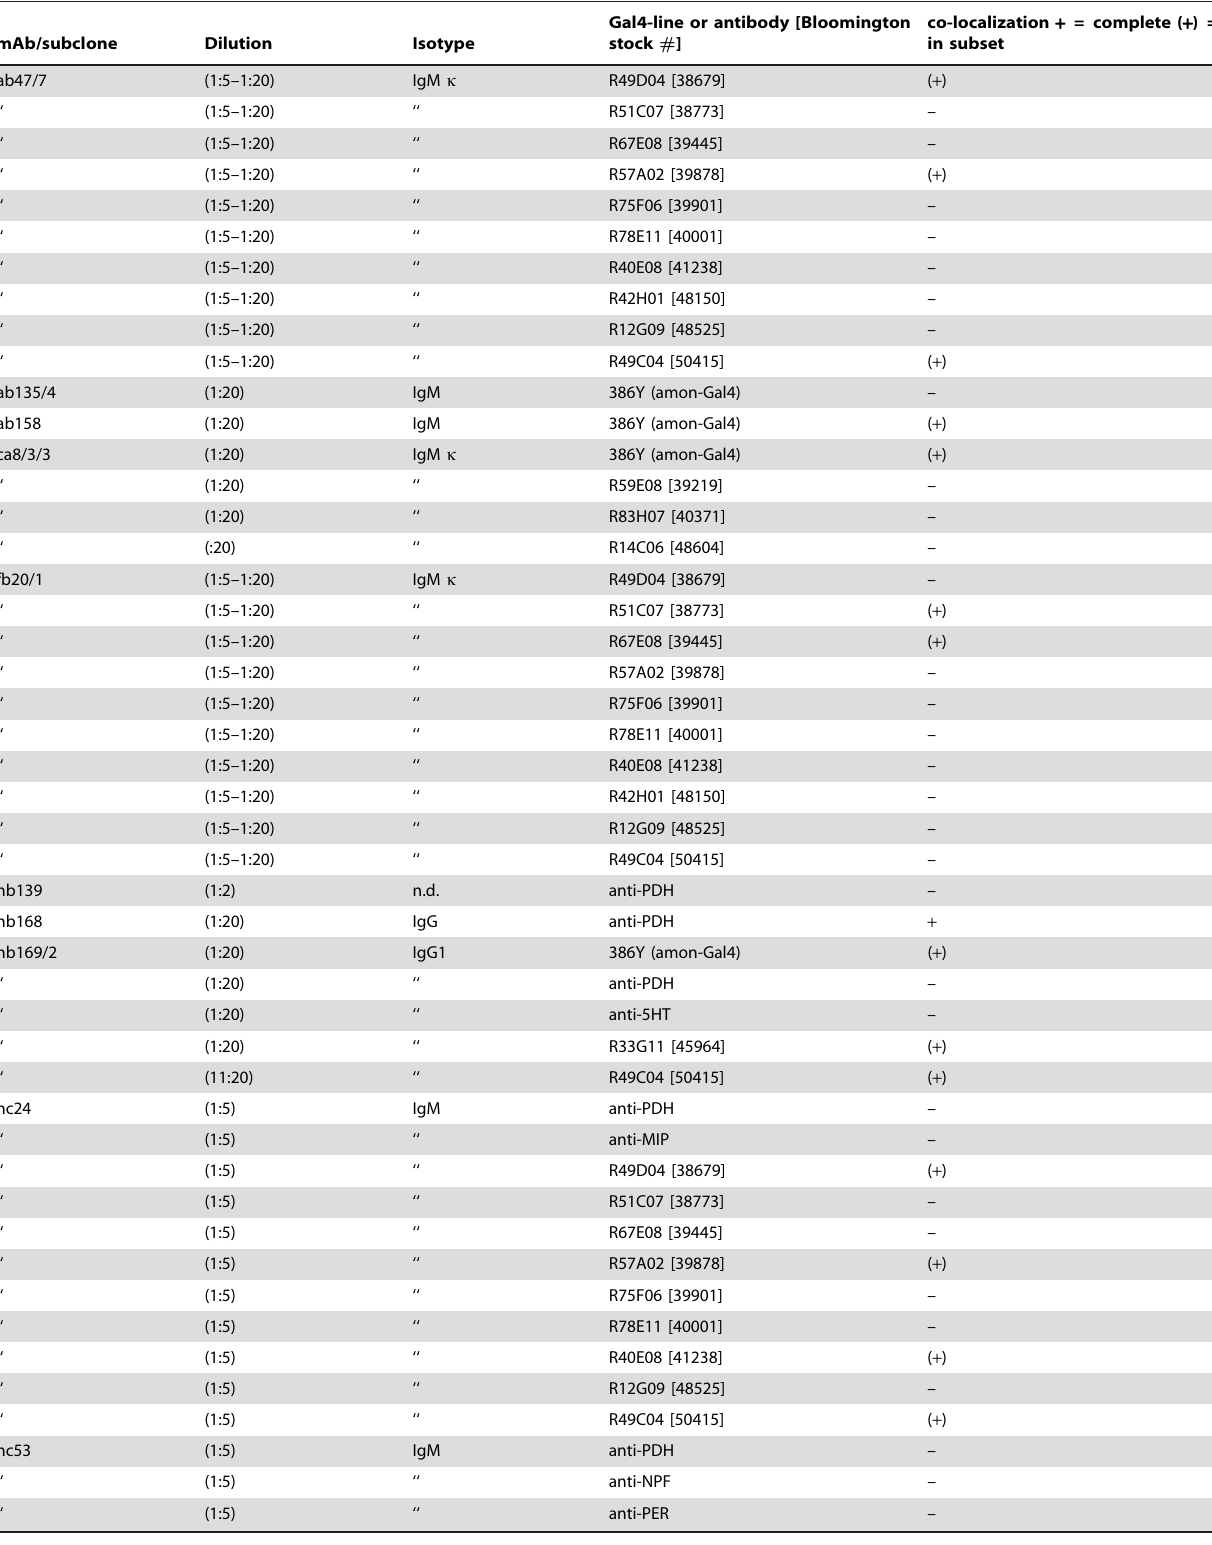
Table 1. List of mAbs compared with GFP (detected by anti-GFP (1:1000) driven by Gal4-lines) or stainings with antibodies against known antigens (pigment dispersing hormone, PDH (1:1500); myoinhibitory peptide, MIP (1:1000); neuropeptide F, NPF (1:300); period protein, PER (1:2000); serotonin, 5HT (1:400)).